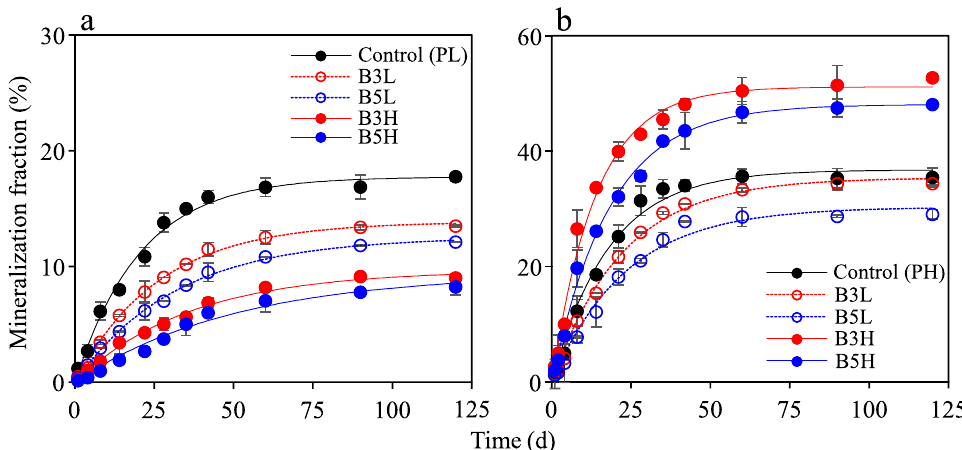
Fig. 1 Microbial mineralization kinetics of phenanthrene in the PLS ( a ) and PHS ( b ) by indigenous microorganisms under various biochar treatments during 120 days of incubation. Control (PL) and Control (PH) indicate soil initially spiked with phenanthrene alone at low (2 mg kg − 1 ) and high (20 mg kg − 1 ) concentrations, respectively. BnL and BnH indicate phenanthrene-spiked soil amended with low (0.03%) and high (0.3%) doses of biochar, respectively. “n” indicates charring temperatures of 300 and 500 °C